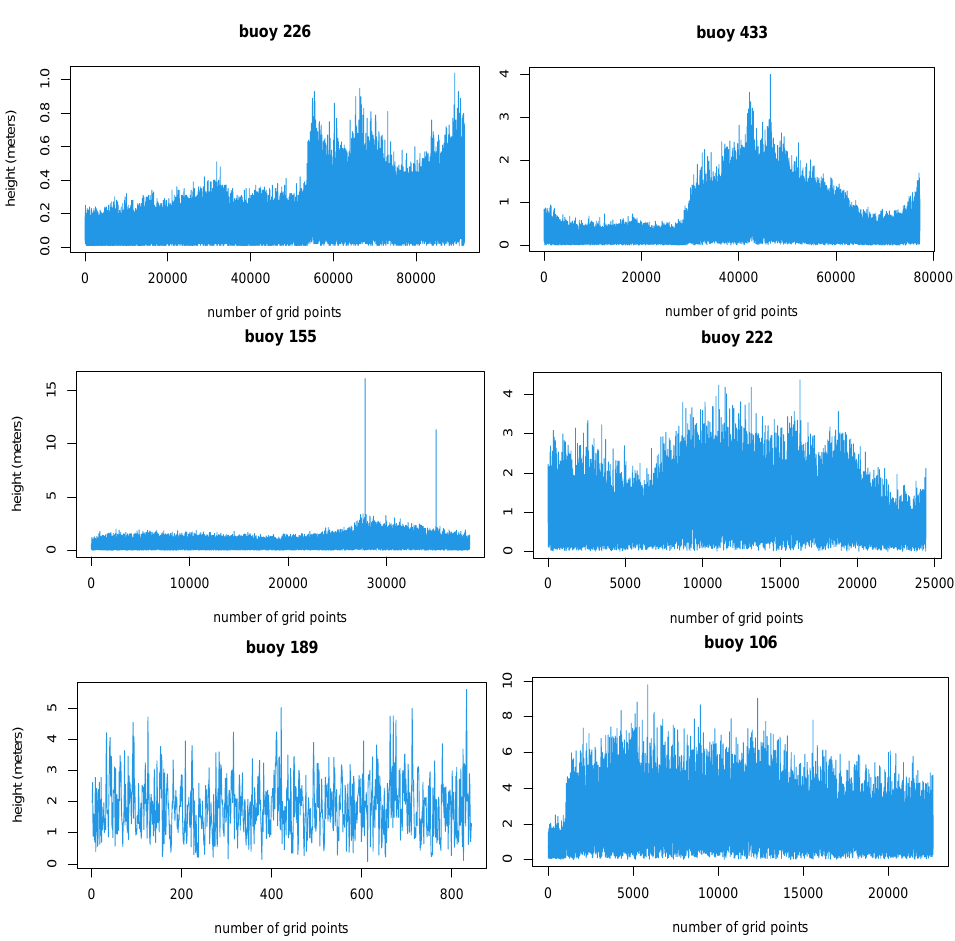
Figure 3. Display of the sea wave height time series for buoys 226, 433, 155, 222, 189, and 106 (from left to right and top to